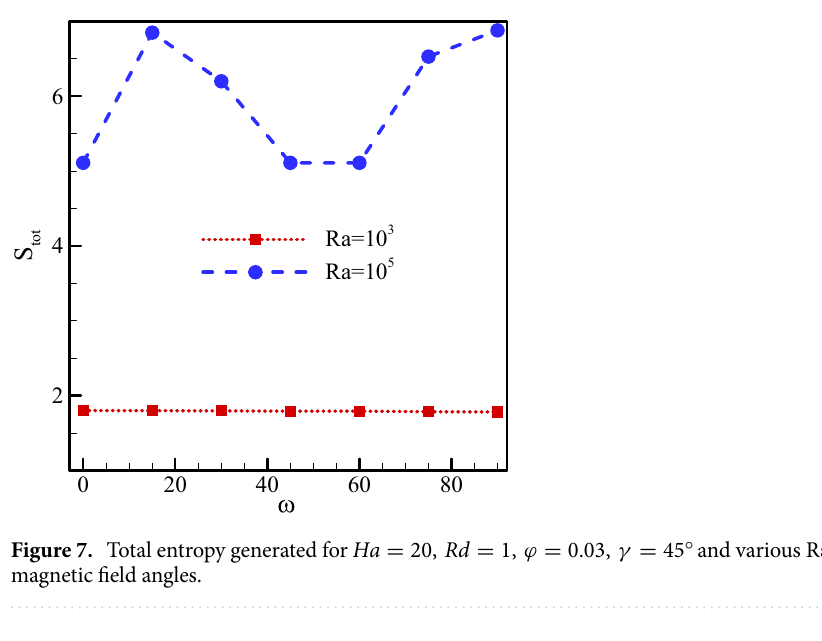
Fig. 8. The Bejan number is a criterion representing the thermal contribution of the S total . A larger Rayleigh num- ber causes a rise in S total . This increase is due to a rise in both the viscous dissipation and the thermal contribution. As shown, the Bejan number falls as the Ra number rises. This is owing to the increase of the total generated entropy with rising Ra number. Since the generated entropy is in the denominator of the Bejan number fraction, its increase has led to a decrease in the Bejan number. Furthermore, a change in ω at low Rayleigh numbers does not impact the Bejan number because of its negligible effect on S total . However, due to the effect of changes in ω on the velocity and temperature gradients at high Rayleigh numbers, these changes can change the Bejan number. Variations in the total generated entropy have caused changes in the Bejan number, such that the lowest Bejan number has occurred at instances with the highest entropy generation.